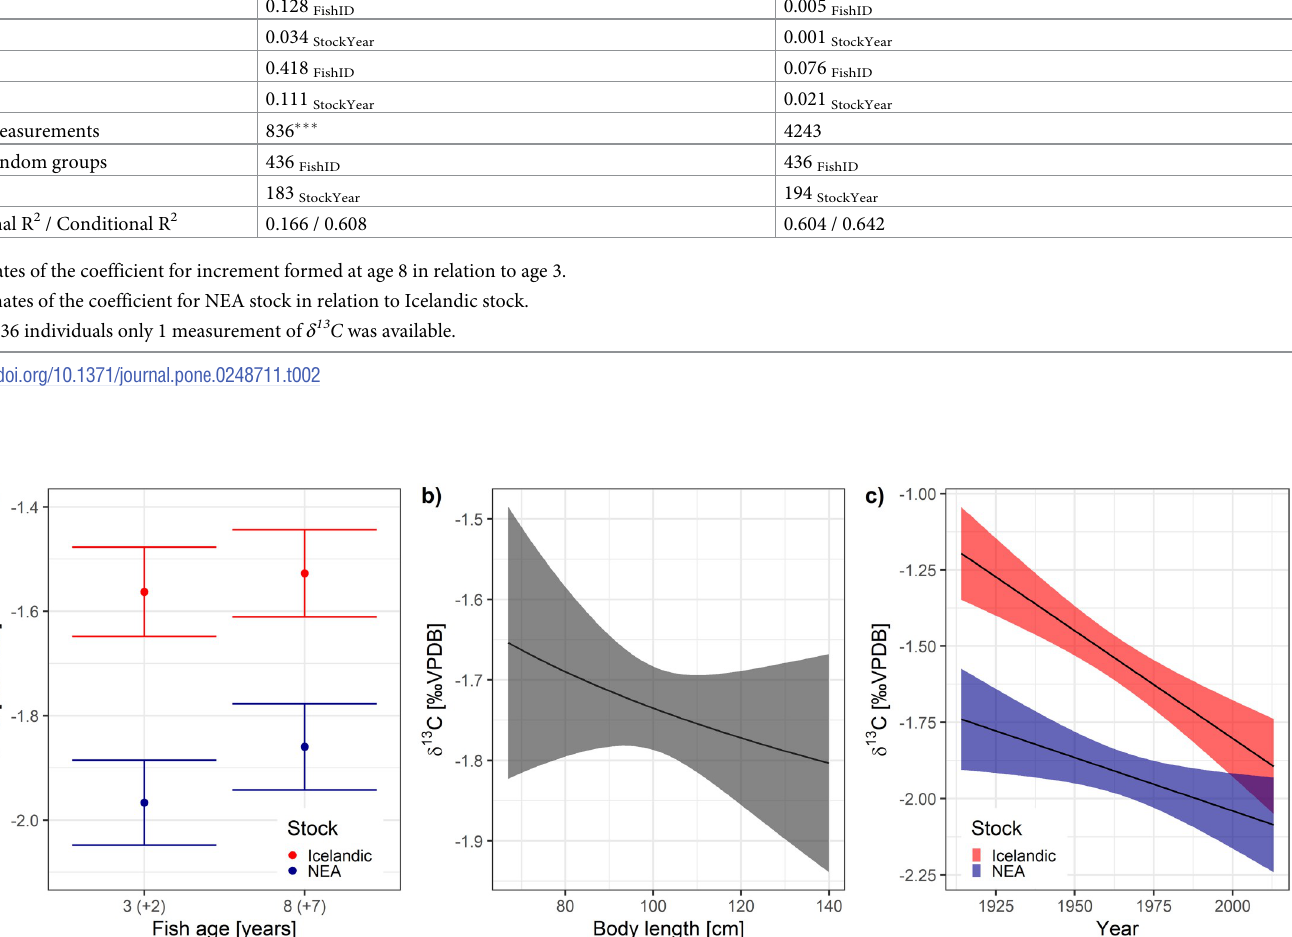
Fig 3. Effects of the variables predicted by the univariate model of carbon isotope ratios selected based on the AICc. The estimated Year slopes (c) which were explained by the oceanic Suess effect were used to correct the δ 13 C oto values prior to the estimation of C resp